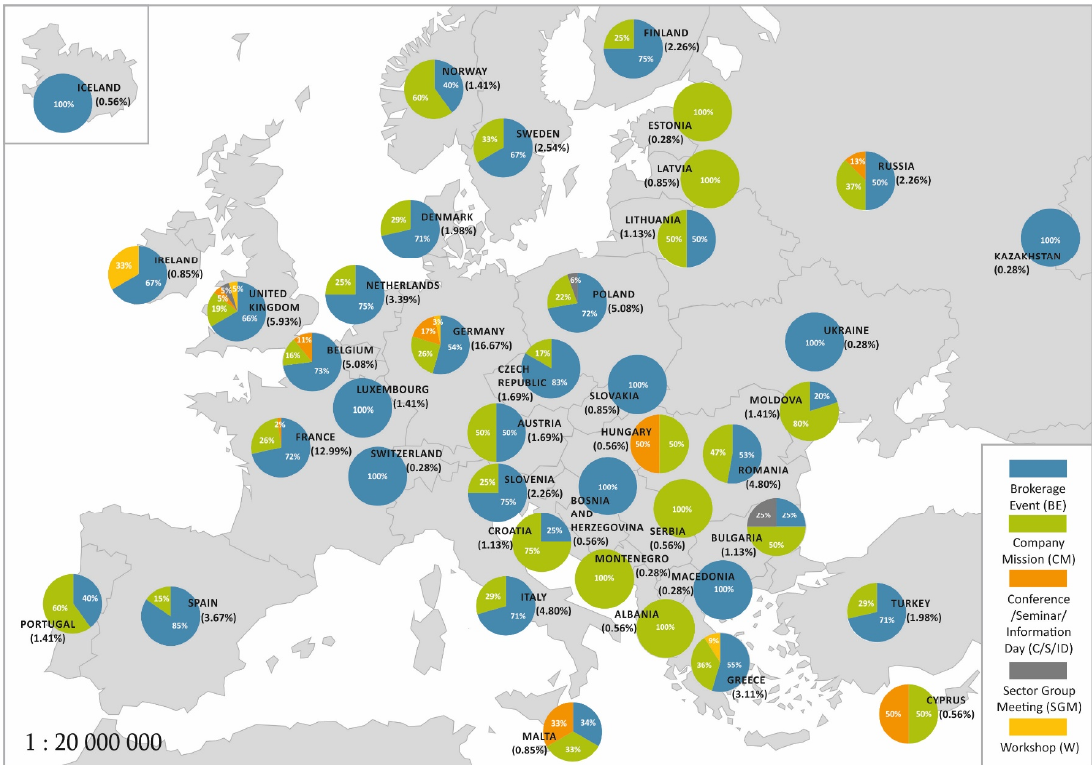
Figure 2. Structure of types of promotional instruments in the EEN in 2017–2018 for selected European countries.